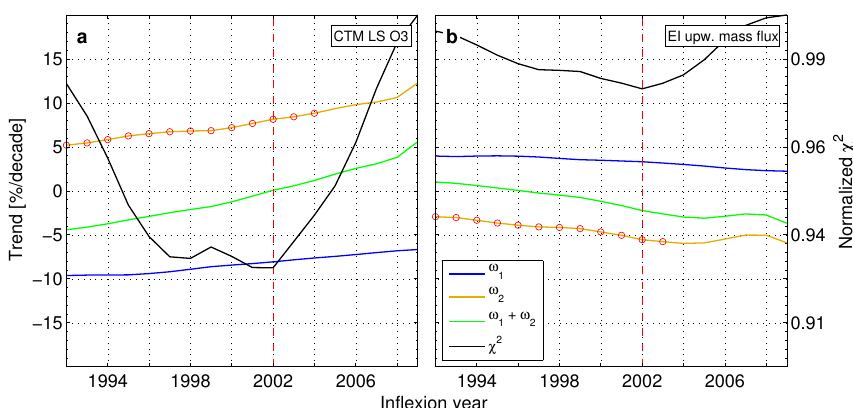
Figure 1. The dependence of the linear fit parameters ω 1 , ω 2 and ω ( ω 1 + ω 2 ) on the inflexion year T 0 is shown for the regression of modelled tropical LS O 3 column ( a ) and EI upward mass flux at 70hPa ( b ). Red circles denote the years where the trend-change ( ω 2 ) exceeds the 95% confidence threshold. The black lines are the normalised χ 2 values of the fit residuals.